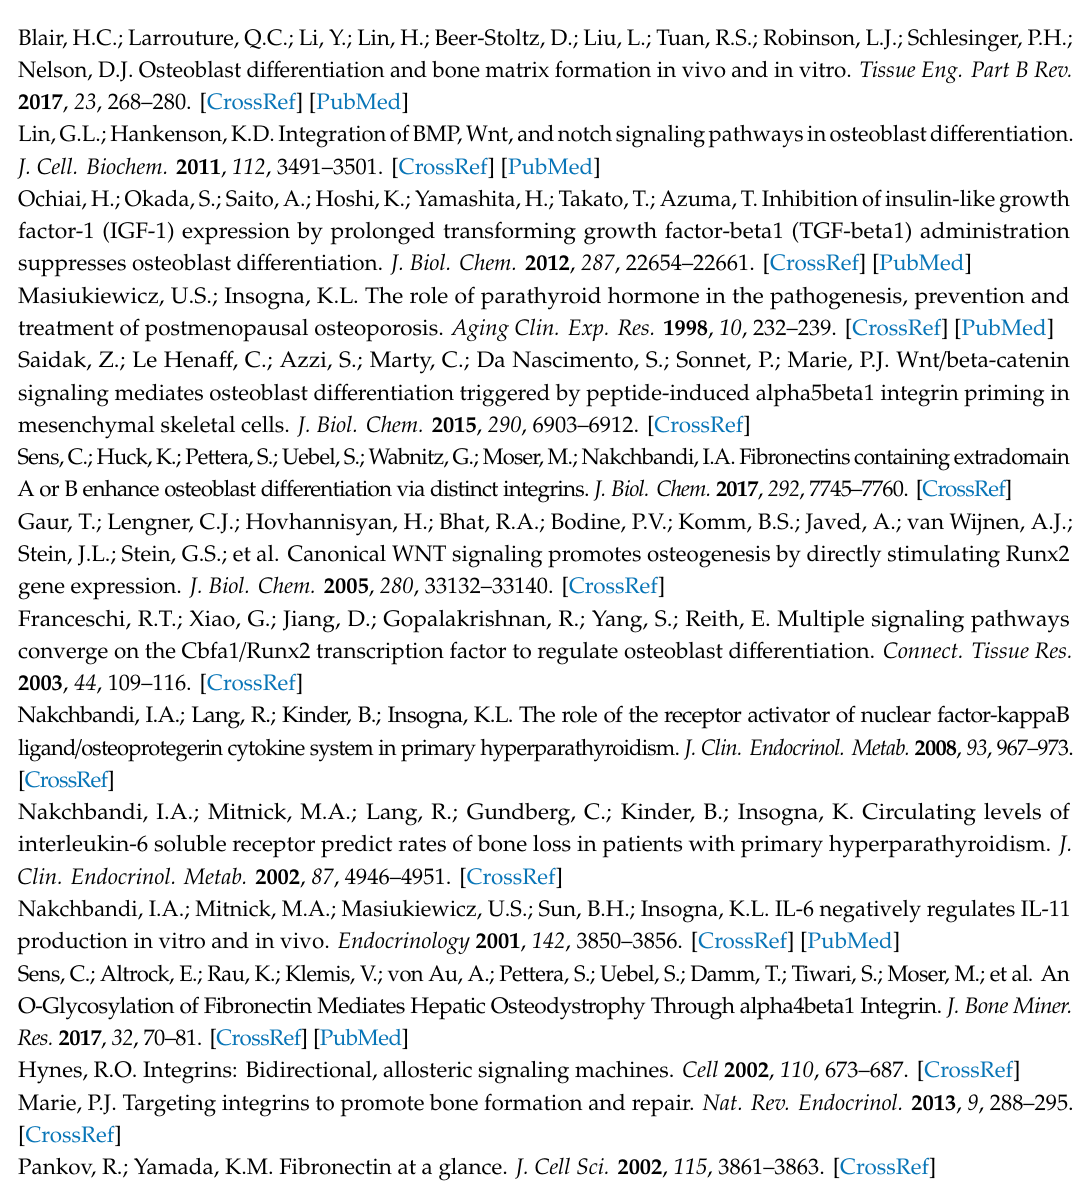
Figure S1: Dose response to a chemical inhibitor of Rac1 in osteoblasts, Supplementary Figure S2: Bone mineral density after one week repression of Osx-cre, Supplementary Figure S3: Bone histomorphometry changes in Osx Rac1 mice compared to CT Rac1 fl / fl